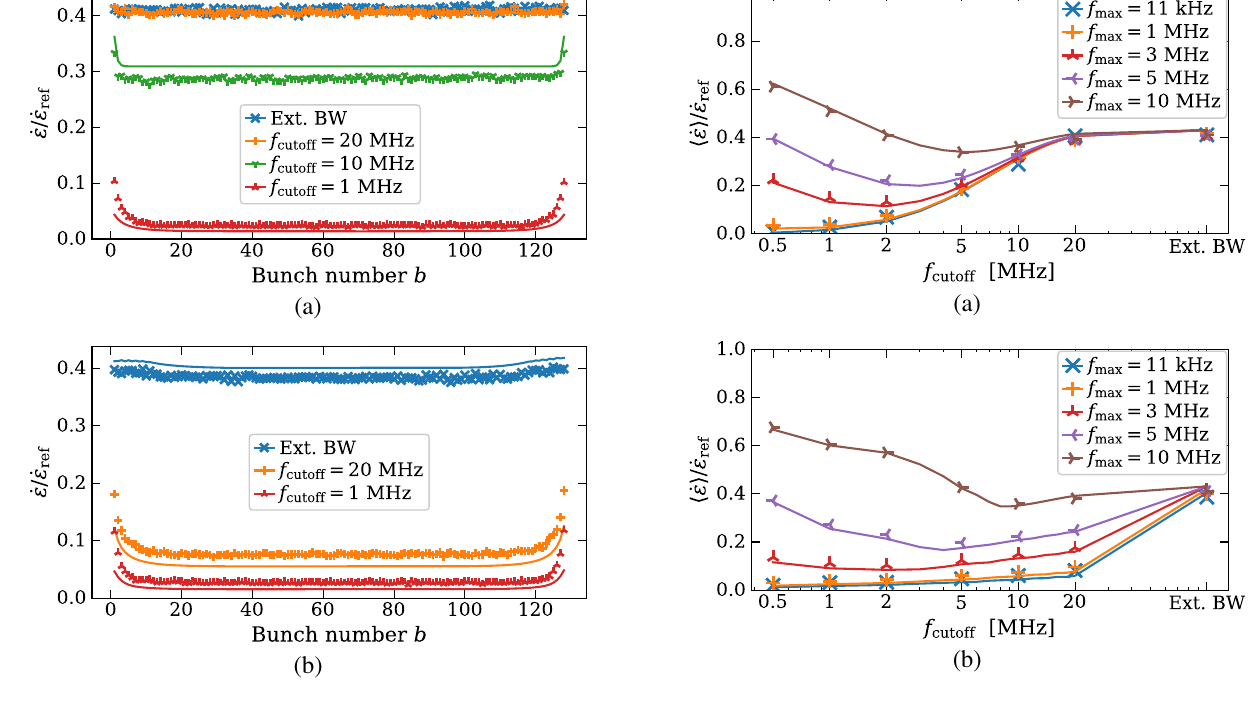
FIG. 2. Emittance growth rate for all 128 neighboring bunches affected by only LF noise, using the EXP filter in (a) and the ADT filter in (b). The solid lines are the expected emittance growth rates, calculated with Eqs. (11) and (17).